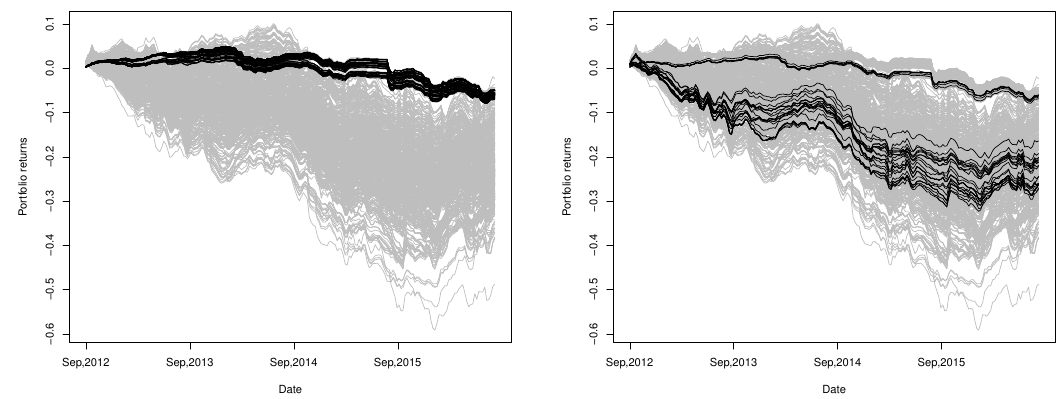
Figure 12. Returns ( black lines ) of the selected minimum variance portfolios based on our clustering procedure (left, 72 portfolios in total) and the procedure proposed by De Luca and Zuccolotto (2011) (right, 32 portfolios in total). Each portfolio consists of four currencies, selected by choosing one currency from each of the four resulting clusters, compared to returns ( gray lines ) of minimum variance portfolios constructed by all combinations (1001 in total) of four currencies out of total 14 currencies.